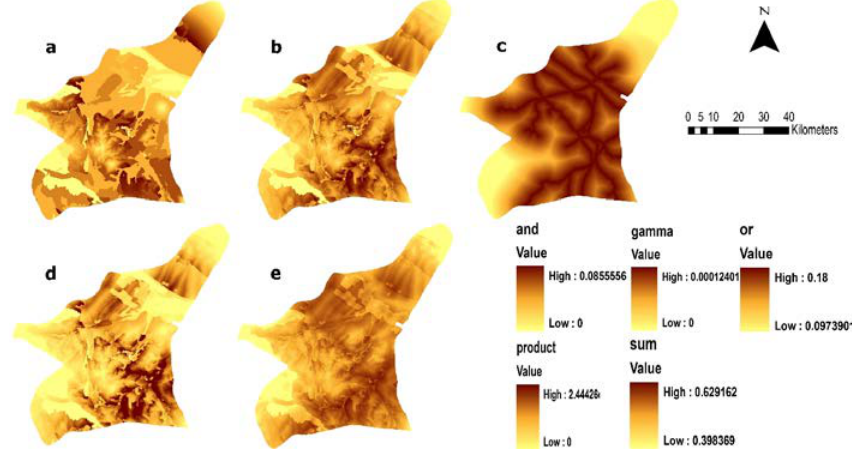
Fig. 6: Site selection of gas power plant by fuzzy operators; a) AND; b) GAMMA; c) SUM; d) PRODUCT; e)